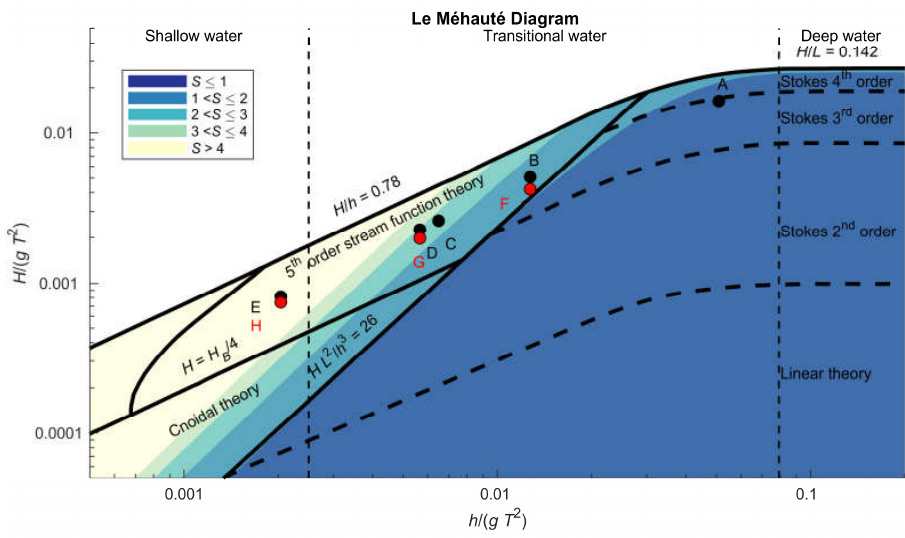
Figure 1. Tested sea states, where black dots are for the regular waves and red dots are for irregular waves. The colored areas show different ranges for the nonlinearity parameter S calculated with Equation (1). (Adapted from Le Méhauté [9]).